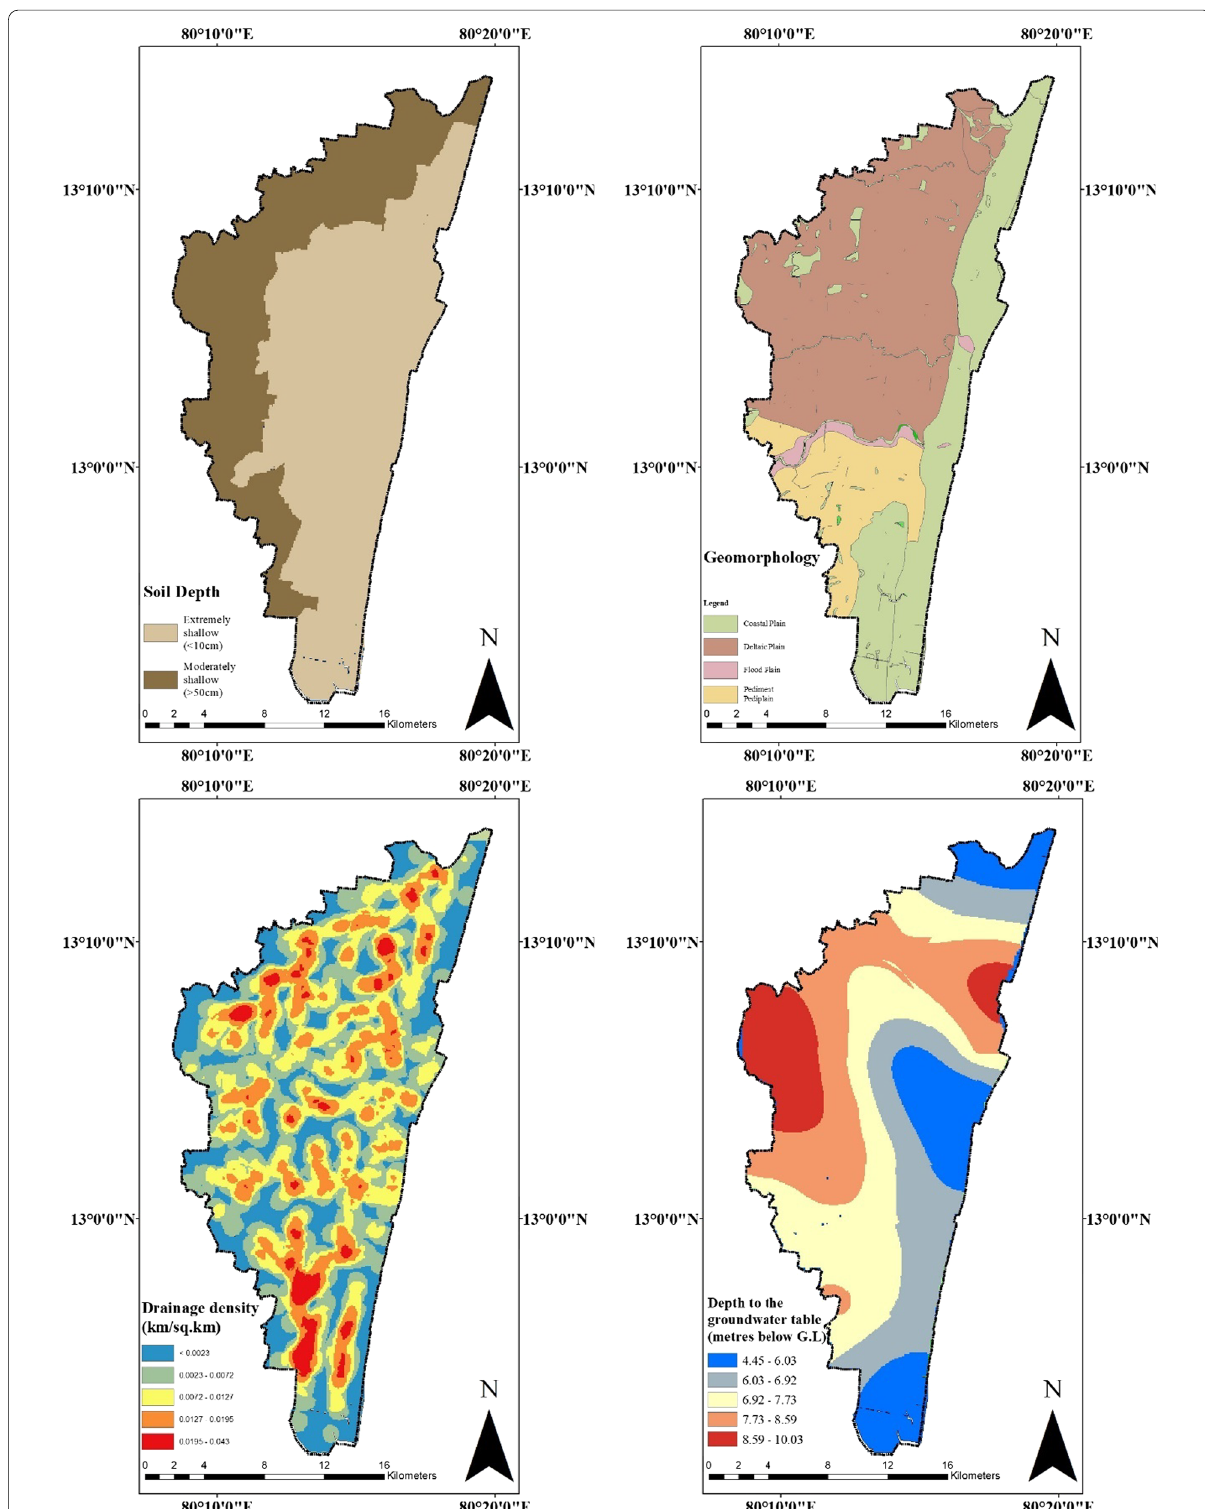
Fig. 3 Soil depth, geomorphology, drainage density and depth to groundwater table